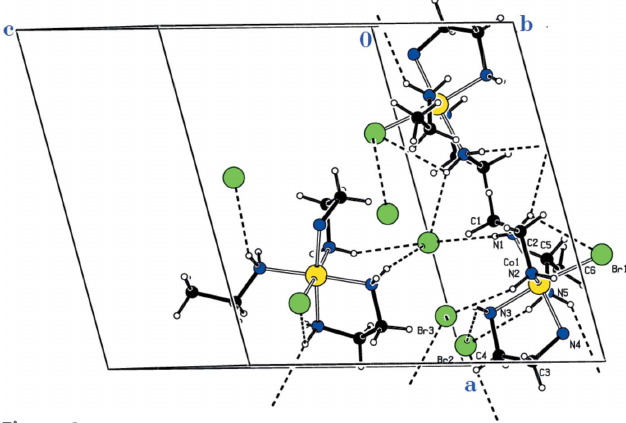
Figure 2 A packing view of the title compound approximately down the b axis. Intermolecular N—H (cid:2)(cid:2)(cid:2) Br contacts are depicted with dashed bonds.